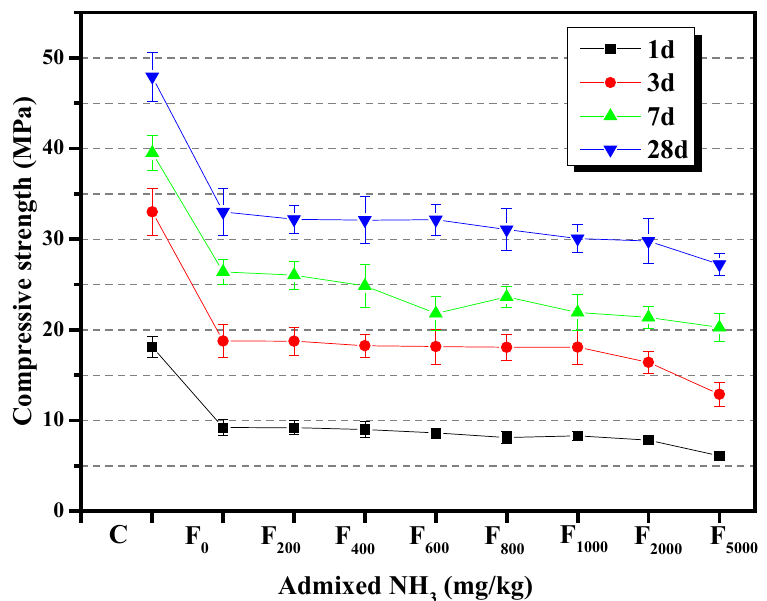
Figure 10. The effect of increasing ammonia content in fly ash on the compressive strength of the resultant cement